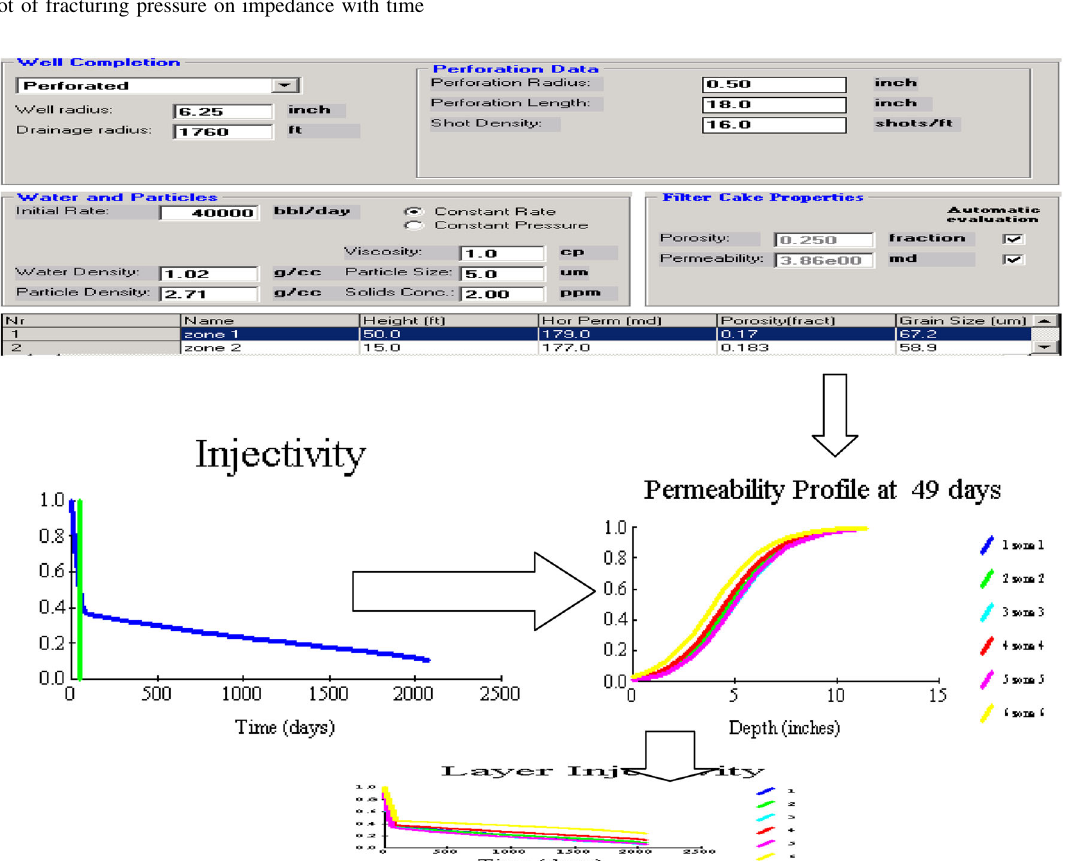
Fig. 10 Profile of injectivity decline of produced water from the Bakasap formation. source: Energy Tech Co, Houston, Texas and Department of Petroleum Resources [Nigeria] as reported by Idialu